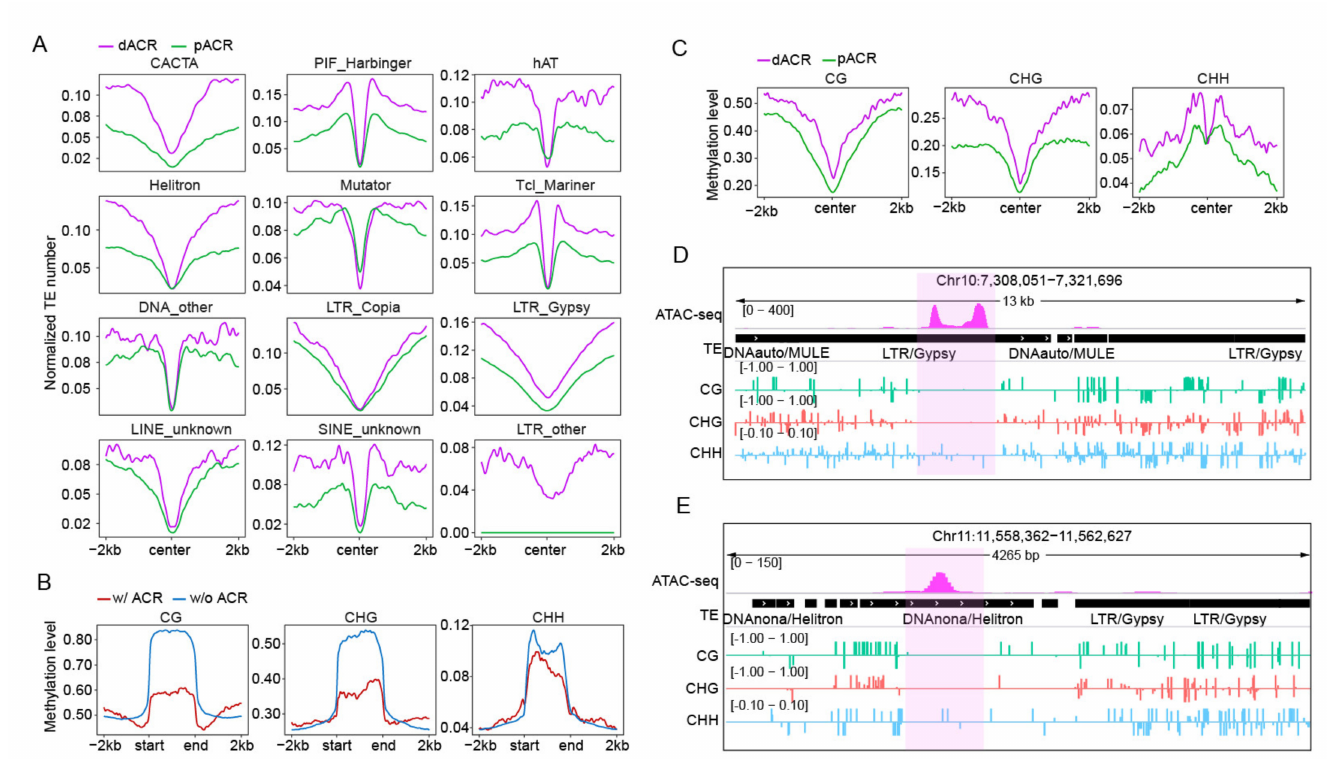
Figure 2. Distributions of TEs around ACRs and the methylation levels of corresponding ACRs and TEs. ( A ) Curve plots showing normalized TE number across ± 2 kb of the center of pACRs (promoter ACRs) and dACRs (distal ACRs). ( B ) Average methylation level (CG, CHG, CHH) dis- tribution over TEs with ( w /) ACRs and without ( w / o ) ACRs. ( C ) The methylation level (CG, CHG, CHH) across ± 2 kb of the center of TE-derived pACRs and dACRs. ( D , E ) IGV snapshots show- ing the methylation level around a Copia retrotransposon-derived ACR ( D ) and a Helitron DNA transposon-derived ACR ( E ), the ACRs were hypomethylated while the other regions located in TEs were